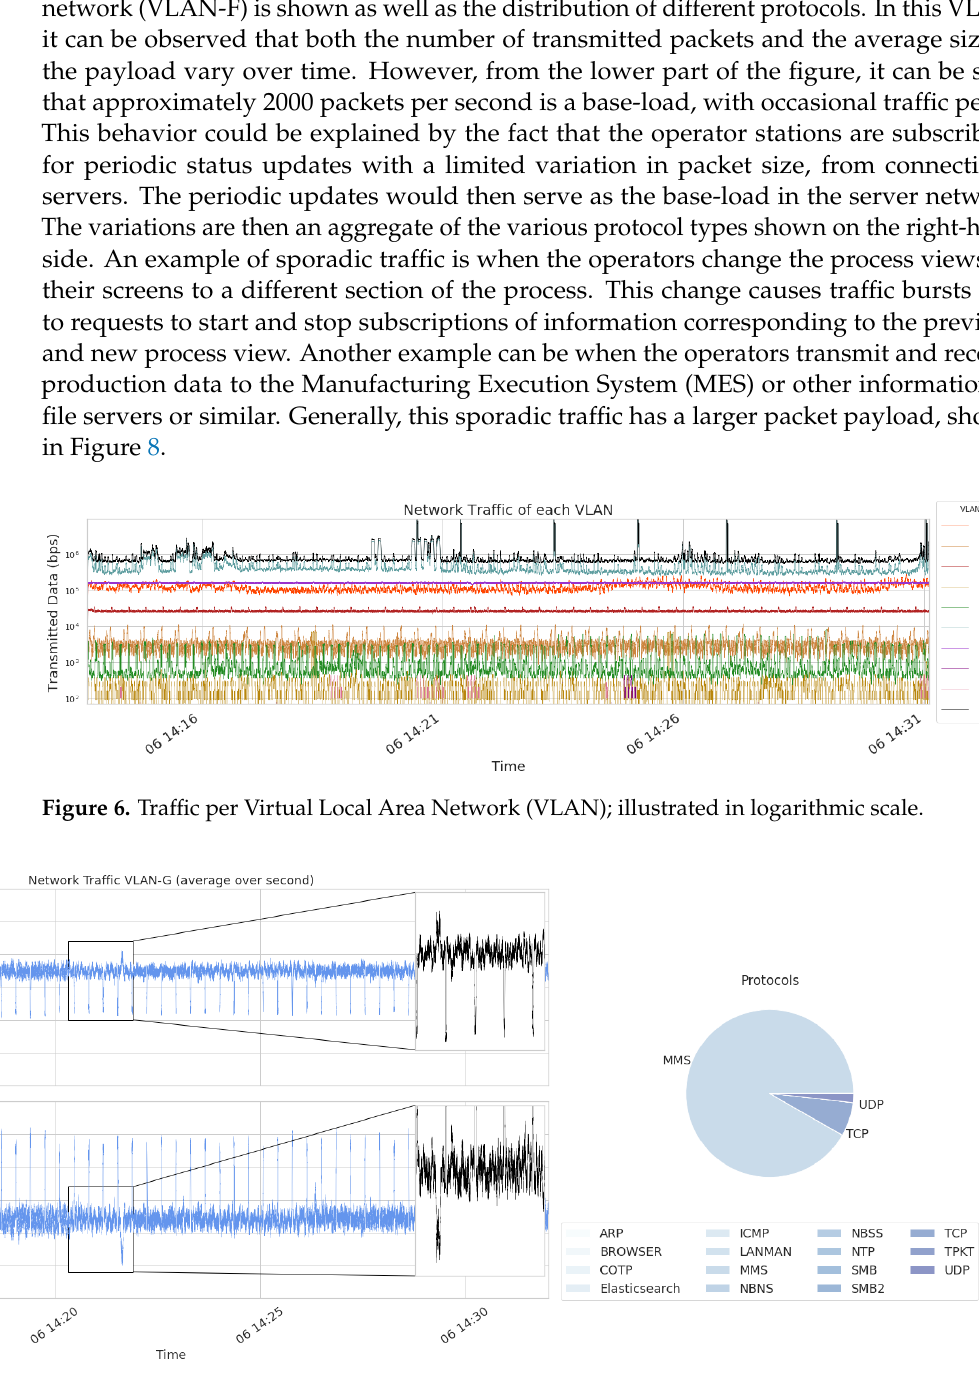
Figure 7. Traffic between AC800Ms and Connectivity Servers in VLAN-G. The pie chart shows the proportion of consumed bandwidth by various communication